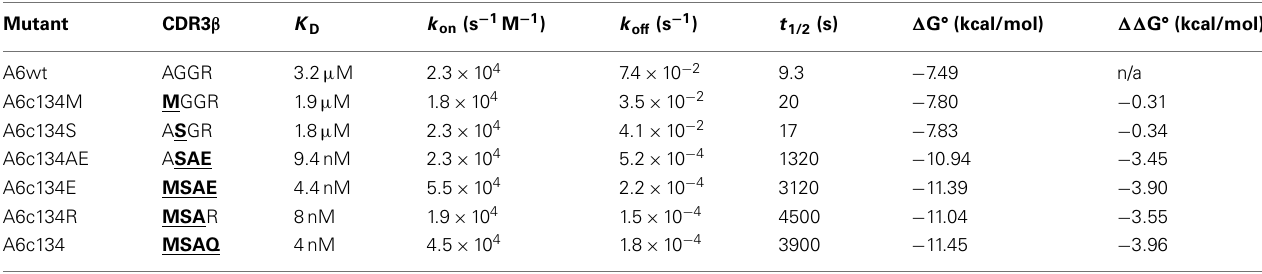
Table 1 | Biophysical analysis of different combinations of “knock-in” and “knock-out” mutations (in bold type and underlined) ofA6wt and A6c134TCRs binding toA2-Tax.